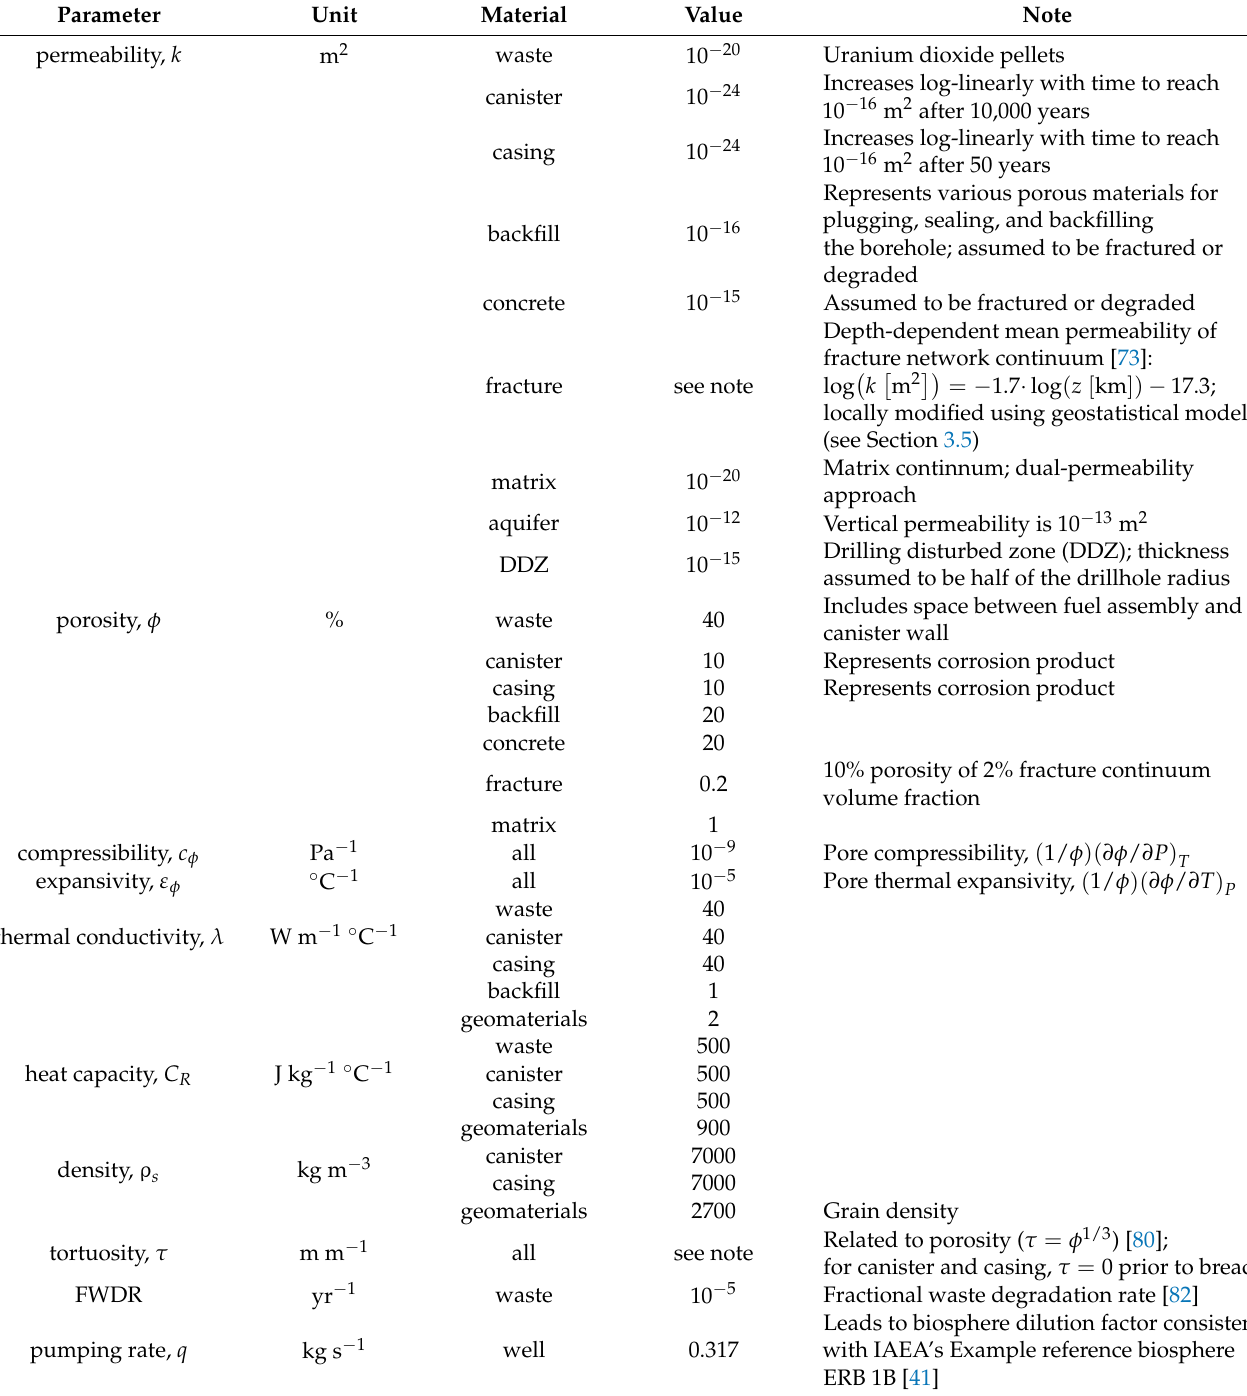
Table 2. Material-specific hydrological, thermal, and transport